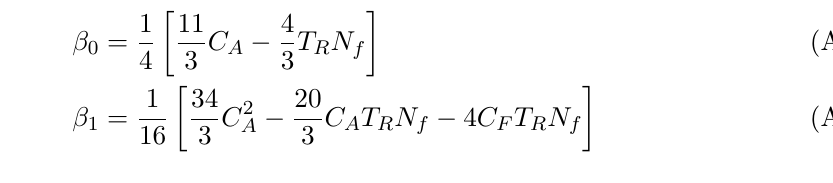
the number of quark (cid:13)avors. The coe(cid:14)cients of f